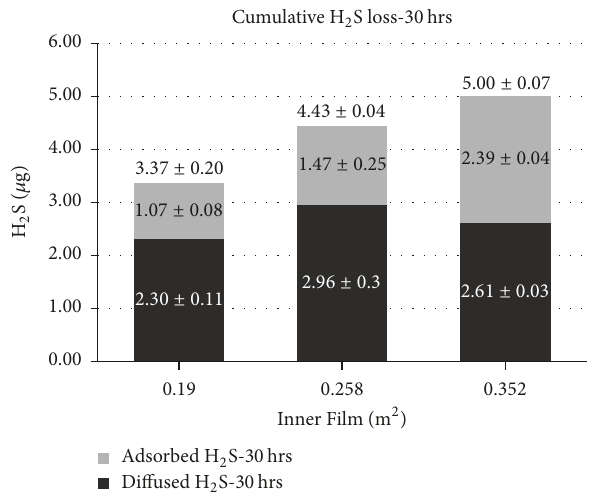
Figure6:TheamountofH 2 Sintermsofcumulativelosses,diffusion losses, and adsorption losses related to the surface of the inner film at a storage temperature of 23 ∘ C and humidity of 20%. The data reported are the average of the results from three different tests performed at the same conditions.